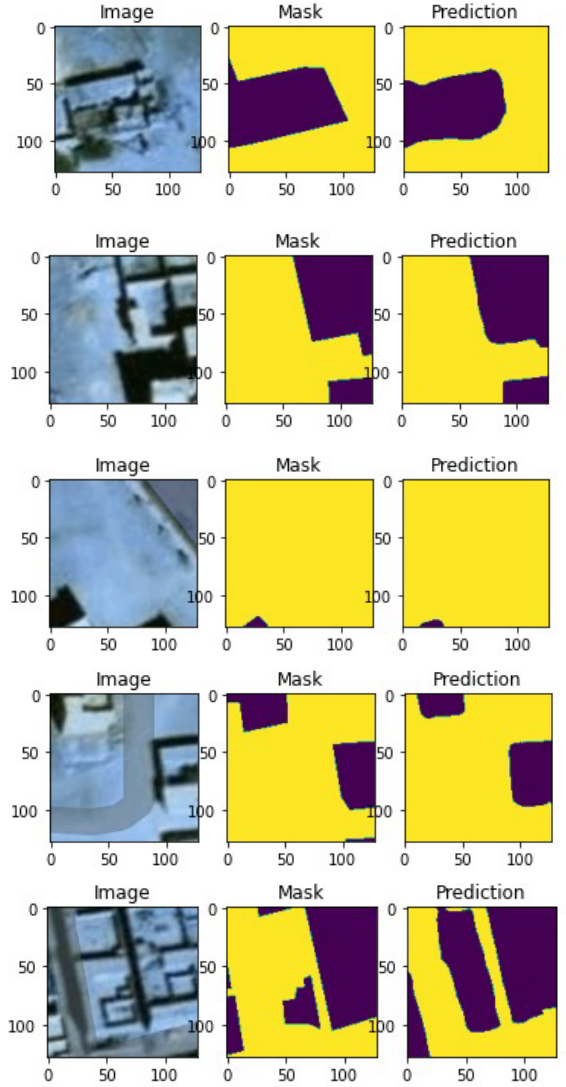
Figure 5 . Comparison of remote sensing original RGB images, ground truth, and U-net algorithm recognition results in indicative regions.